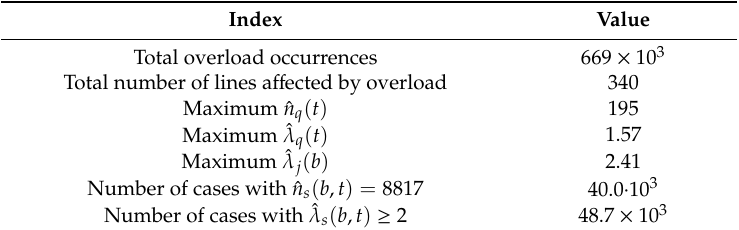
Table 4. Yearly network performances in N − 1 condition (lines in service–hours).